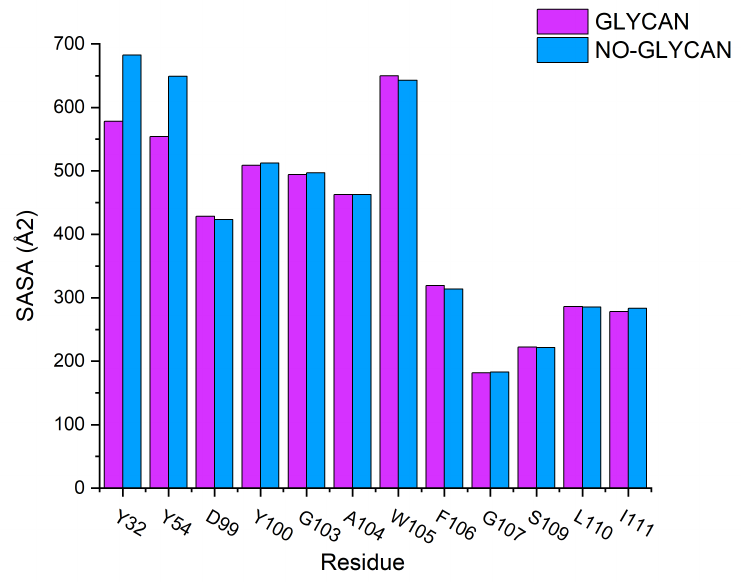
Figure 5. Calculation of solvent accessible surface area: GLYCAN for the purple column and NO- GLYCAN for the blue